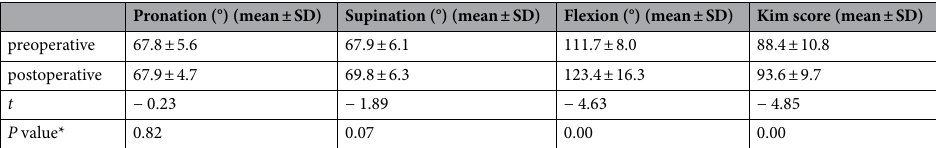
Table 2. Pre- and postoperative range of movement and Kim elbow score ( ˜ x ± s ). * t test; P ≤ 0.05, statistically